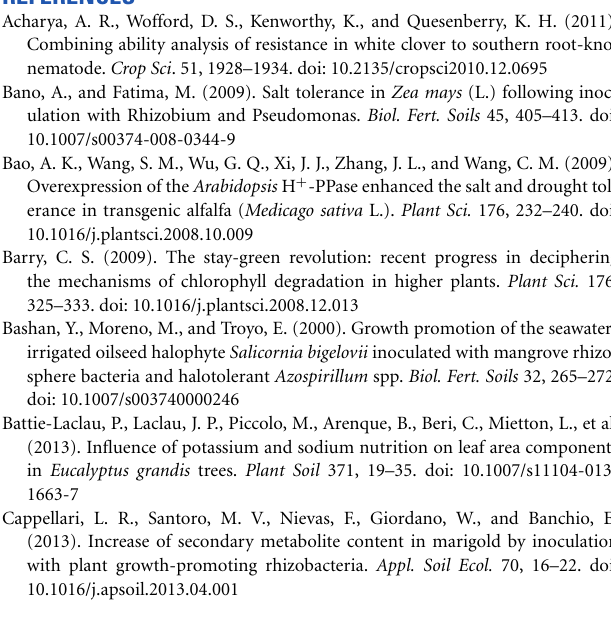
Supplementary Figure 1 | Effects of bacterization on growth of white clover plants in pots under various concentrations of NaCl. Here GB03 represents Bacillus subtilis GB03 suspension culture in LB medium, LB Luria Broth medium without bacteria and 0, 50, 100, and 150 the concentrations of NaCl